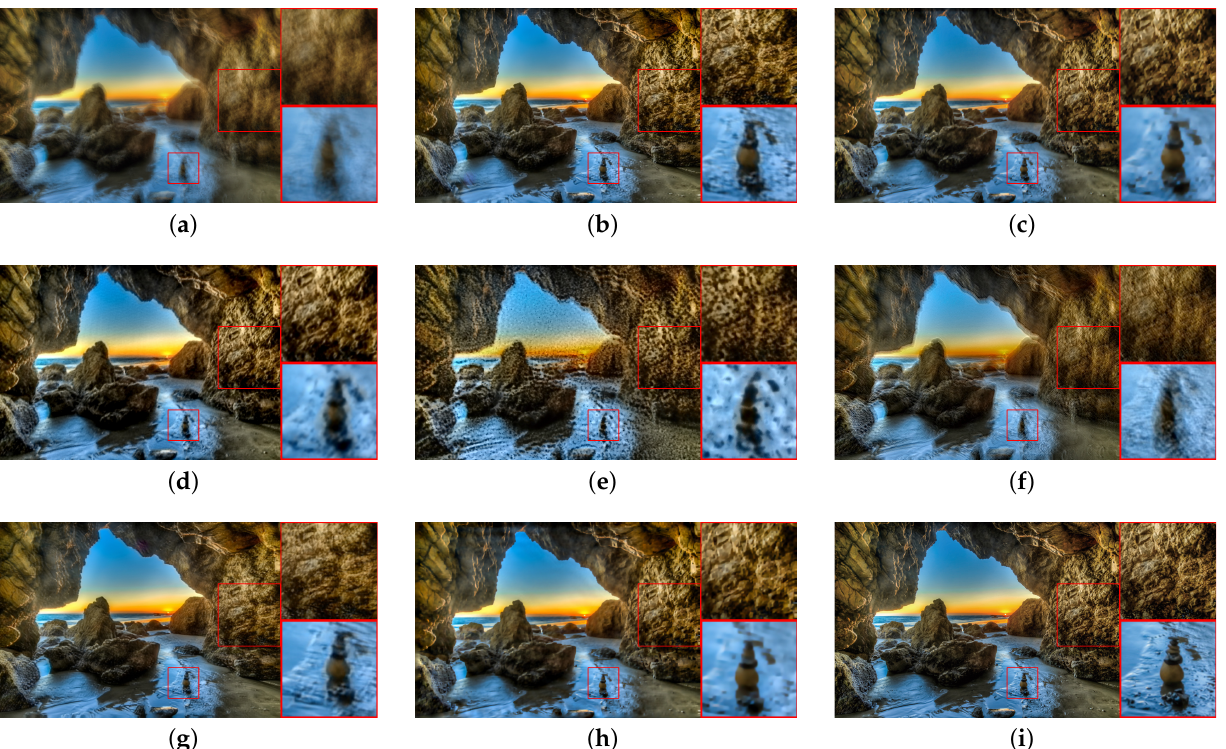
Figure 7. Lai dataset test results. ( a ) Blur image; ( b ) DeblurGAN-v2; ( c ) ResCGAN; ( d ) Self-Deblur; ( e ) UML-IN; ( f ) UML-IN + SSIM; ( g ) UML-IN + L 1; ( h ) UML-IN + L 1 + SSIM; ( i ) Ground